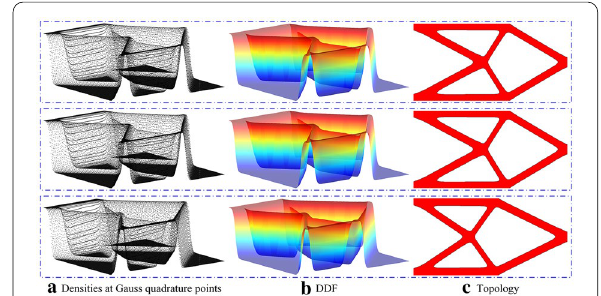
Figure 4 Some numerical results in Ref.